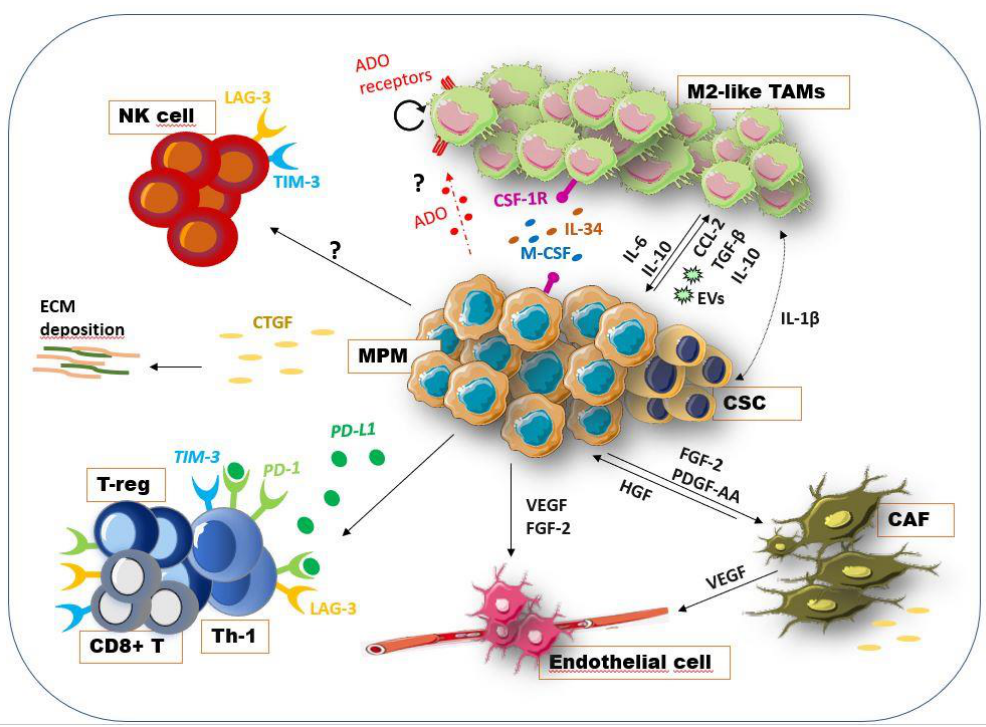
Figure 2. Cellular and soluble factors in MPM-ME. The interconnection between tumor cells and the surrounding stromal and immune component is necessary to create a permissive environment for cancer growth, immune escape and invasiveness [59]. Tumor cells, by the release of the growth factors FGF-2 and PDGF-AA, recruited fibroblast at tumor sites promoting their pro-tumoral activity as CAFs. In turn, these CAFs secreted the HGFs, produced ECM-related proteins, expressed the CTGF and other cytokines supporting tumor growth [65,66]. Additionally, MPM cells have been found to express the CTGF as modulator of ECM-related proteins and supporter of cancer invasiveness [62]. CAFs as well as tumor cells, via the release of the angiogenic VEGF, promoted the recruitment of endothelial cells and the vasculogenesis [67,69,70]. Exhausted Th and CD8 + T cells are also present in TME, characterized by the expression of immune checkpoint molecules, such as PD-1, TIM3, LAG3 [72]. Moreover, PD-L1 signaling induced Th cells reprogramming in Treg cells [73]. Moreover, the NK cells showed an immunosuppressive phenotype and low cytotoxicity [77]. TAMs, which represent the most abundant immune population [36], are recruited at tumor sites by tumor-produced CCL2 [92]. MPM cells enhance the malignancy of macrophages via the release of TGF- β , IL-10, exosomes (EVs) and M-CSF [36]. The presence of M-CSF and IL-34 was associated with short survival and chemoresistance [98,99]. Recently, the inhibition of CSF-1R has been shown to reduce mesothelioma progression and increase the susceptibility of MPM to immune checkpoint inhibitors [101]. The activation of the IL-1 β /IL-1R signaling pathway in tumors by TAMs is correlated with the acquisition of a CSC-like phenotype [96]. As observed in other tumor types, adenosine (ADO) pathways may be involved in MM cells-TAMs interaction, inducing the release of pro-tumoral cytokines and promoting TAMs proliferation [115,127,128]. Although limited data indicate its involvement in MPM immunosuppression [117], a deep investigation is required. This figure was prepared using a template on the Servier medical art website